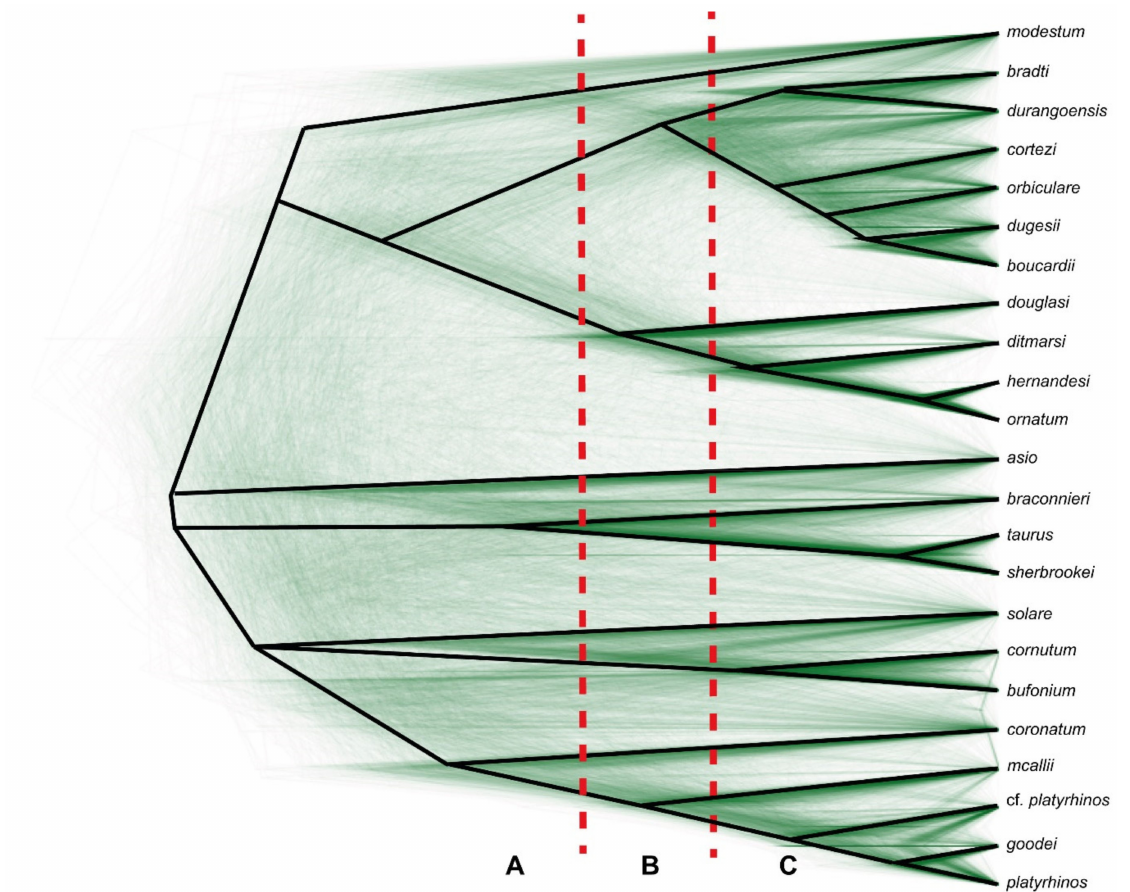
Figure 2. Species tree inferred with BEAST based on the ND4 dataset, showing density of trees proportional to frequency of occurrence, drawn in DensiTree. The vertical dashed red lines roughly indicate the percentage difference defining my categories A, B, and C (see text for